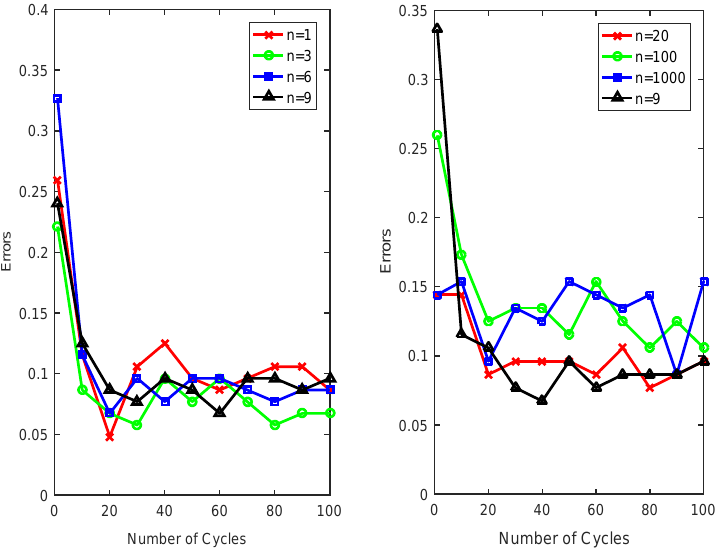
Figure 9. Classification errors using different α m ∗ with different n s.